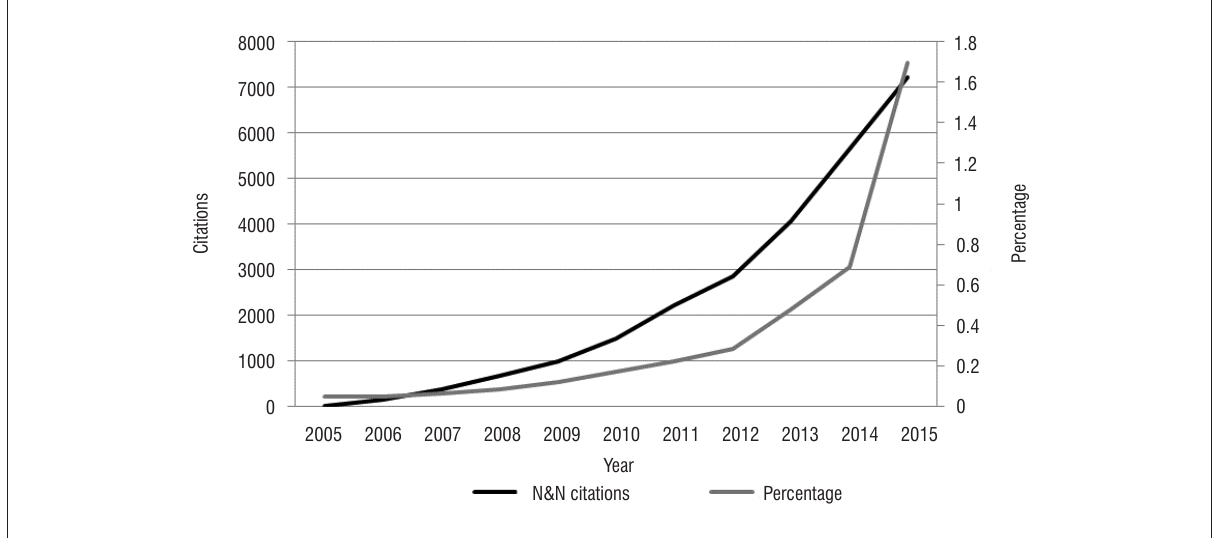
Figure 2: The citation trend as well as percentage of citation of nanoscience and nanotechnology (N&N) articles relative to the total number of citations in South Africa from 2005 to 2015.